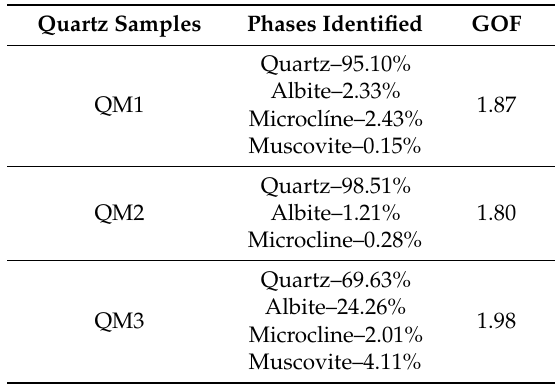
Table 3. Quantification of the phases present in the quartz and feldspar samples, using Rietveld refinement of XRD spectra.